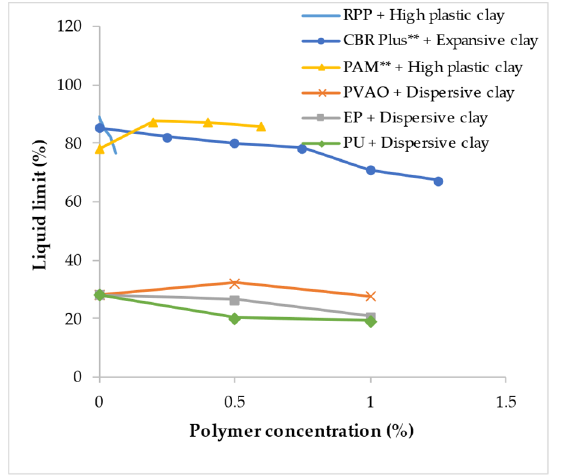
Figure 1. Variation in the Atterberg limit resulting from polymer inclusion at high concentration: ( a ) Liquid limit; ( b ) Plastic limit (* indicates polymer concentration as a % of dry weight of soil and ** as a % of weight of water). Note: these figures were created with data obtained from [65,108,109,122,139–143,147].